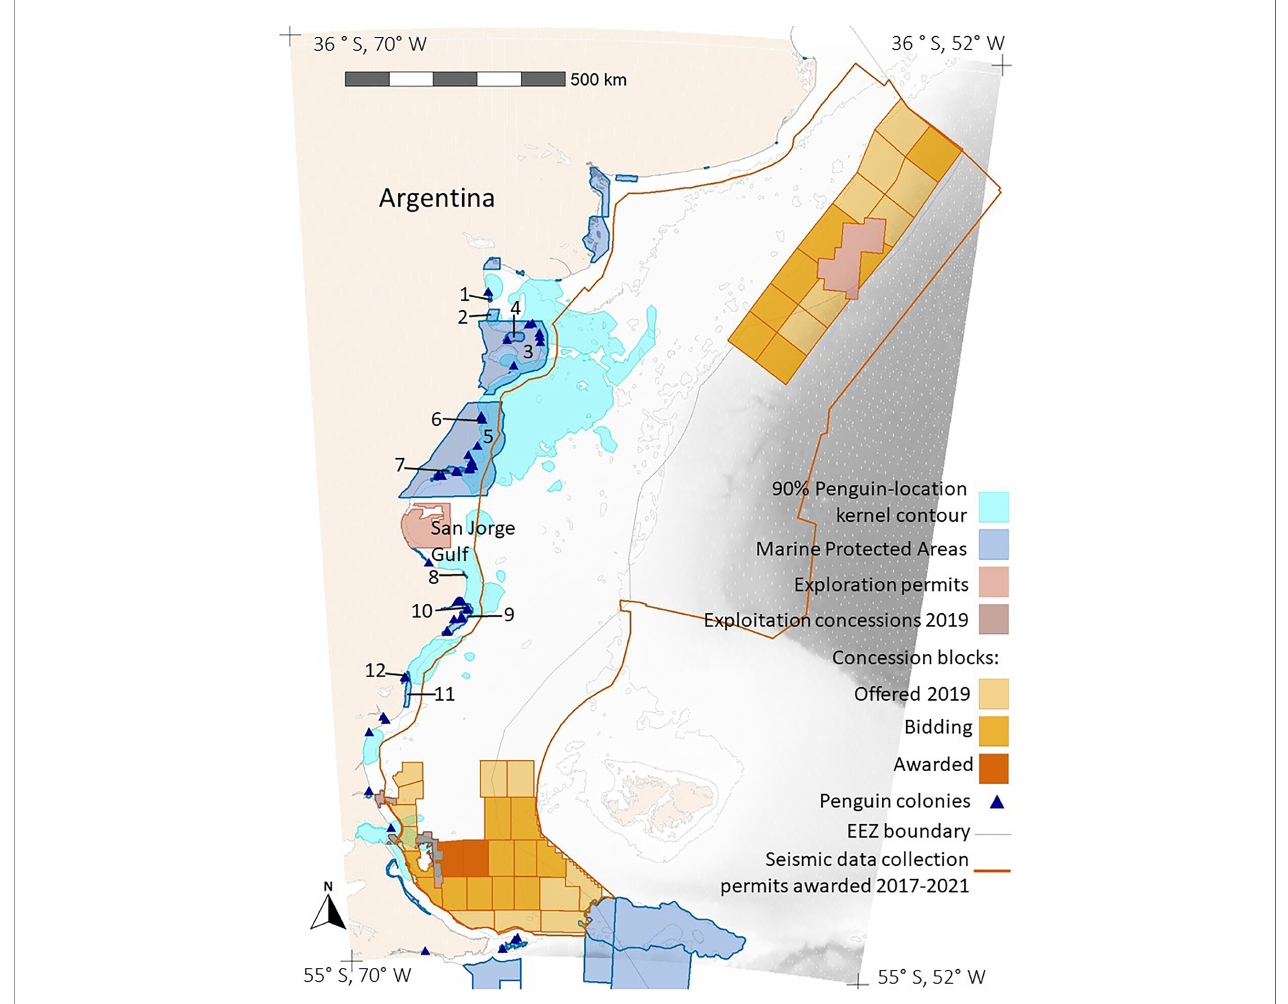
FIGURE 4 | Overlap between foraging areas of Magellanic penguins breeding at 10 colonies in Argentina (90% Penguin-location kernel contour; all colonies combined) and hydrocarbon concessions in Argentina (Exploration permits, Exploitation concessions 2019, and Concession blocks). The tan color is land. Shades of gray indicate ocean depth, with white indicating the continental shelf (< 120 m). The thin gray line marks boundaries of Argentina ’ s exclusive economic zone (EEZ boundary). The dark orange line encloses the area where Argentina awarded seismic-data collection permits in 2017-2021 (Seismic data collection permits awarded). The numbers label the MPAs. See Table S3 for the MPA